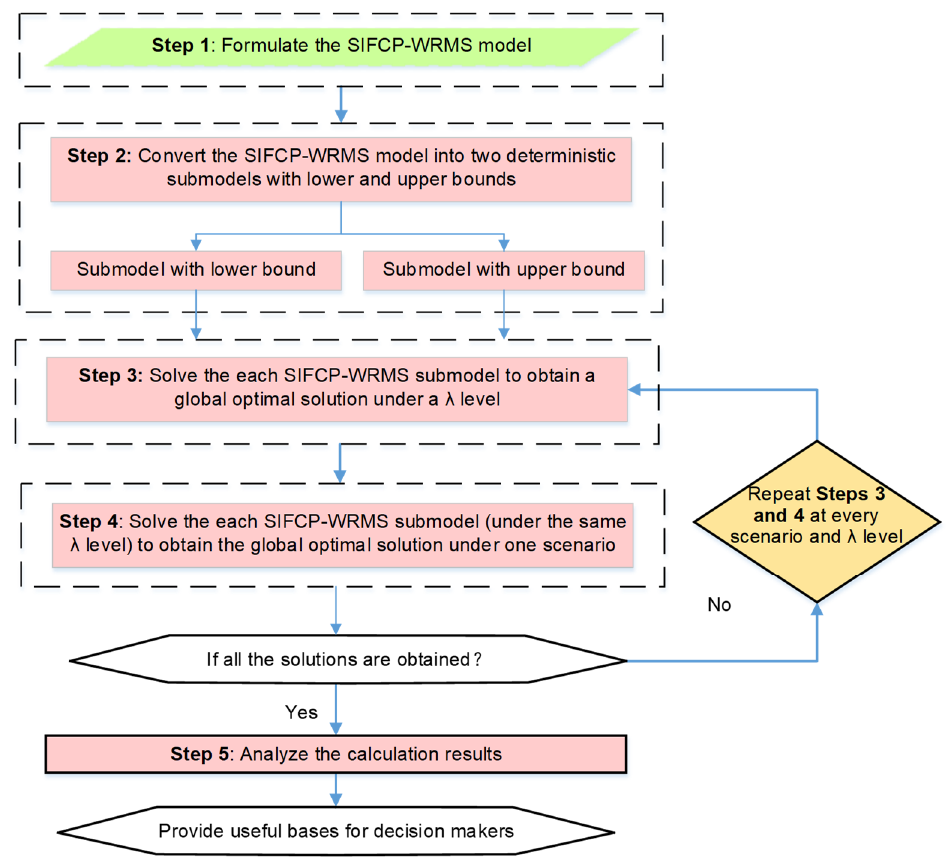
Figure 2. The solution process of SIFCP-WRMS model.